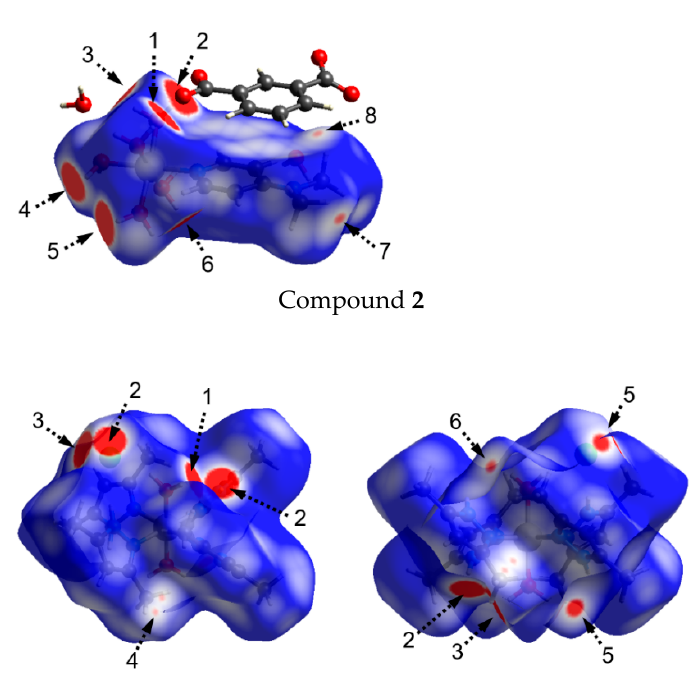
Figure 9. View of the Hirshfeld surfaces of 1 (top) and 2 (bottom) mapped over d norm property. For 2 , the second molecule is rotated by 180° around the horizontal axis of the plot. The labels are discussed in the text. Compound 2 : The red regions labeled 1 and 3 in the d norm surface (Figure 9) are